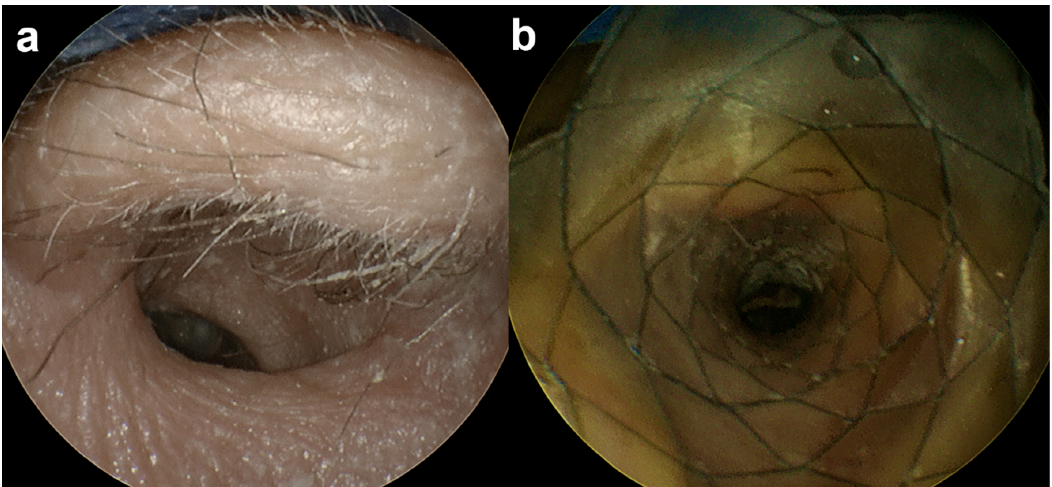
Figure 3. Endoscopic images showing the view at the pinna. ( a ) Endoscopic image showing hairs and irregular external auditory canal (EAC) anatomy. ( b ) Endoscopic image taken immediately after fully covered self-expandable retainer placement showing the expanded and straightened EAC.